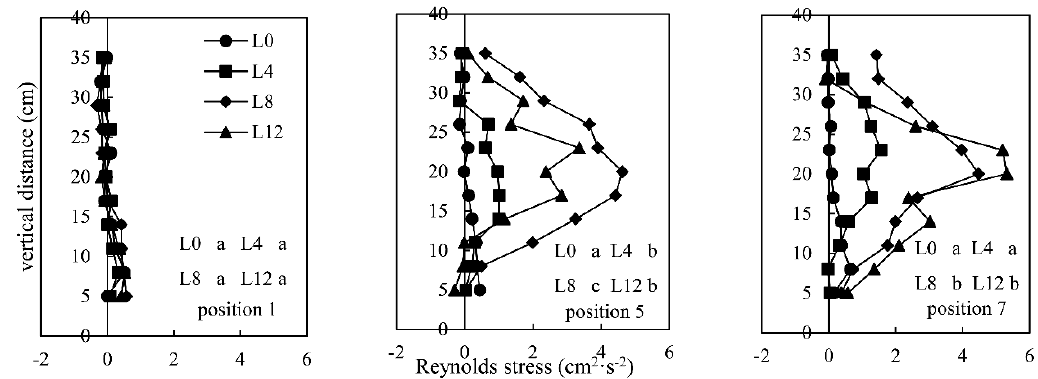
Figure 6. Reynold’s stress under different leaf numbers (note: values within a position followed by the same letter are not significantly different (LSD, p < 0.05)).